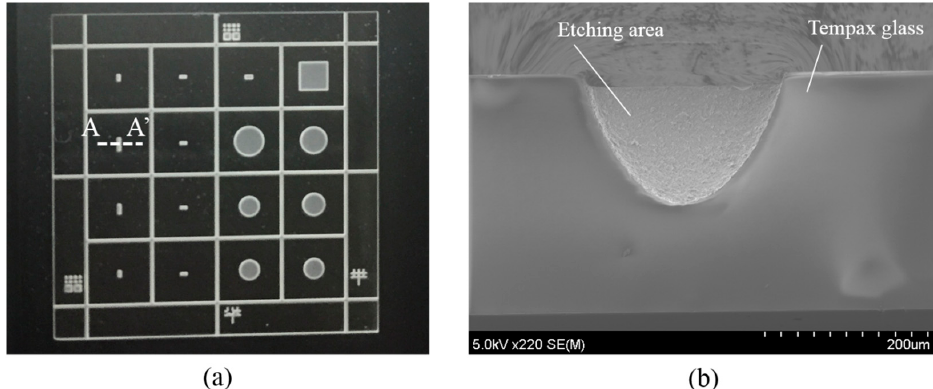
Figure 3. Illustration images for sandblast results. ( a ) Sandblast result on 2 cm × 2 cm Tempax glass wafer; ( b ) A-A ′ cross session.